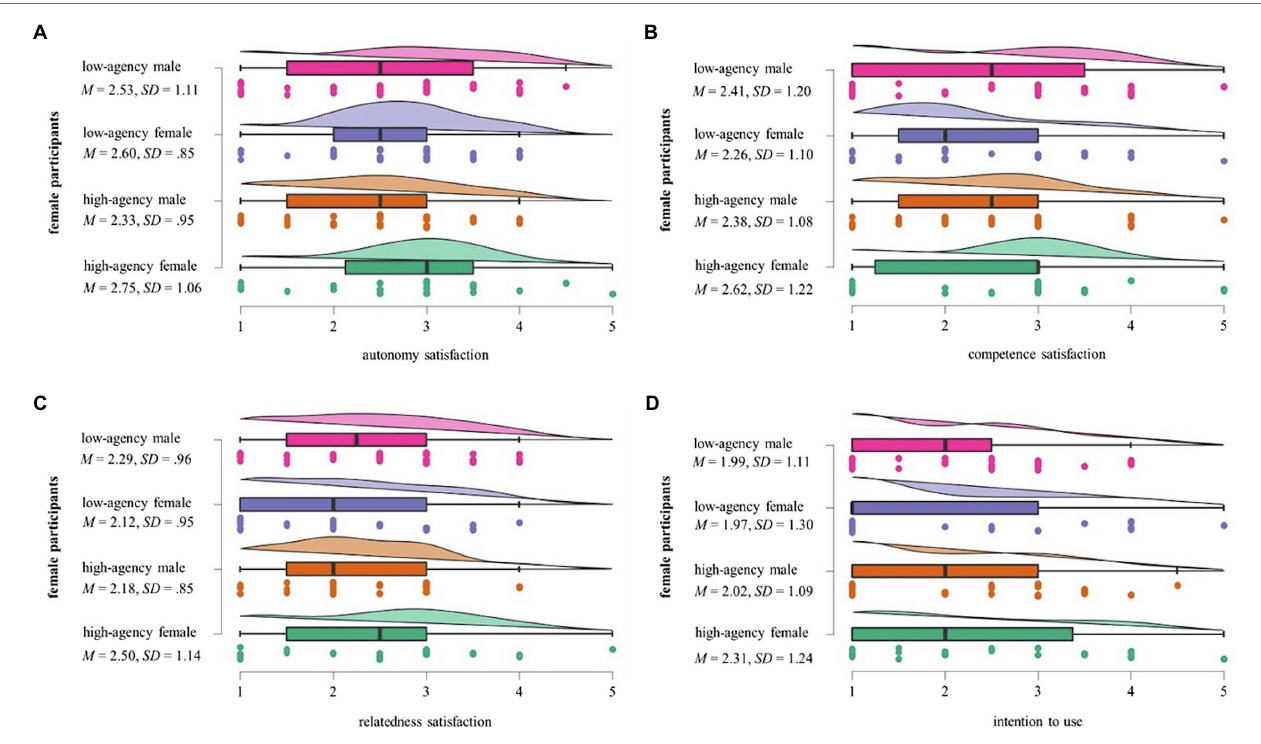
FIGURE 3 | Female participants’ mean scores for the four finance coach type